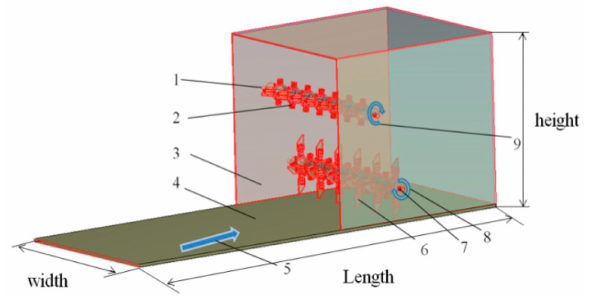
Figure 3. Simplified numerical model of jujube branch picking mechanism. 1. Upper gear shaft 2. Upper gear 3. Device shell 4. Conveyor 5. Movement direction of conveyer belt 6. Lower gear 7. Lower gear shaft 8. Counterclockwise rotation 9. Clockwise